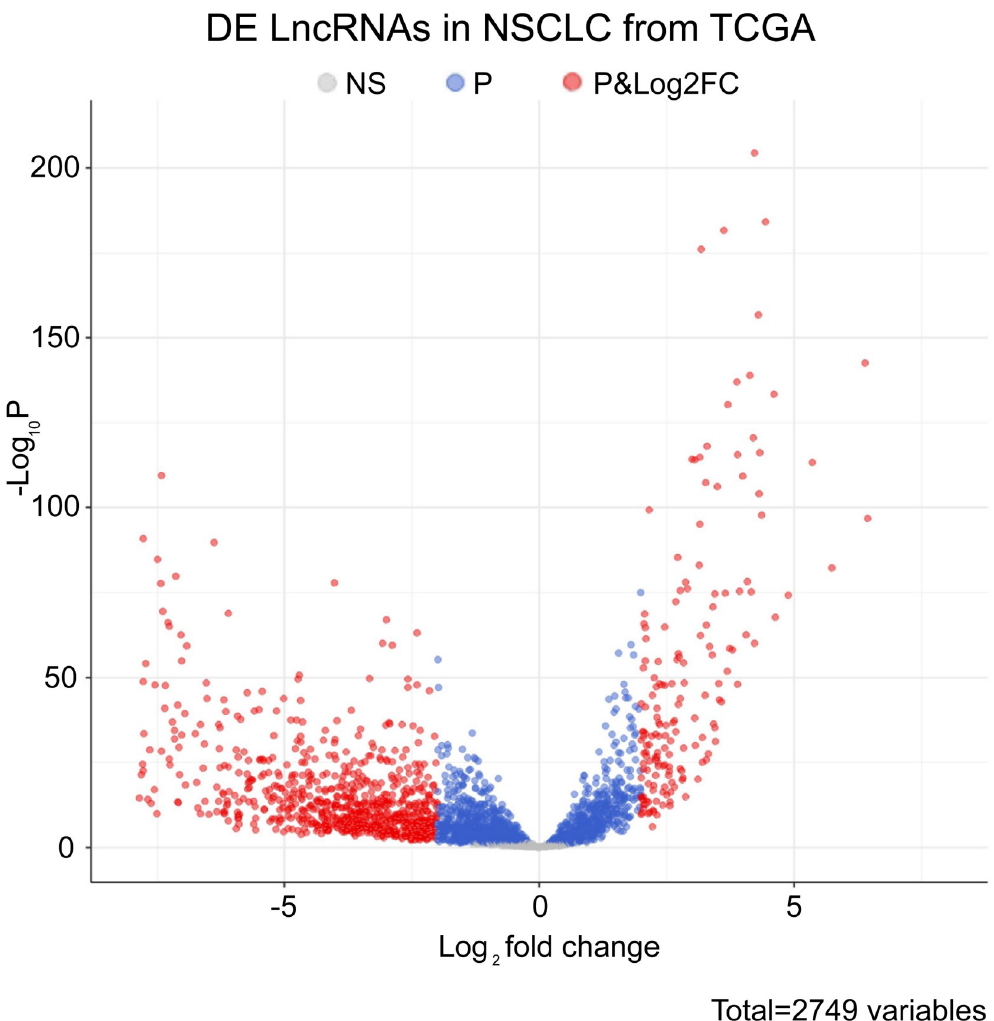
Fig 1. The differential expression of lncRNA volcano plot in cancer tissues and adjacent tissues. The ordinate is the p- value, and the log2 value of the screening condition was used as the abscissa. Upregulated genes and downregulated genes were marked in light red (|logFC| > 2 and P-value <